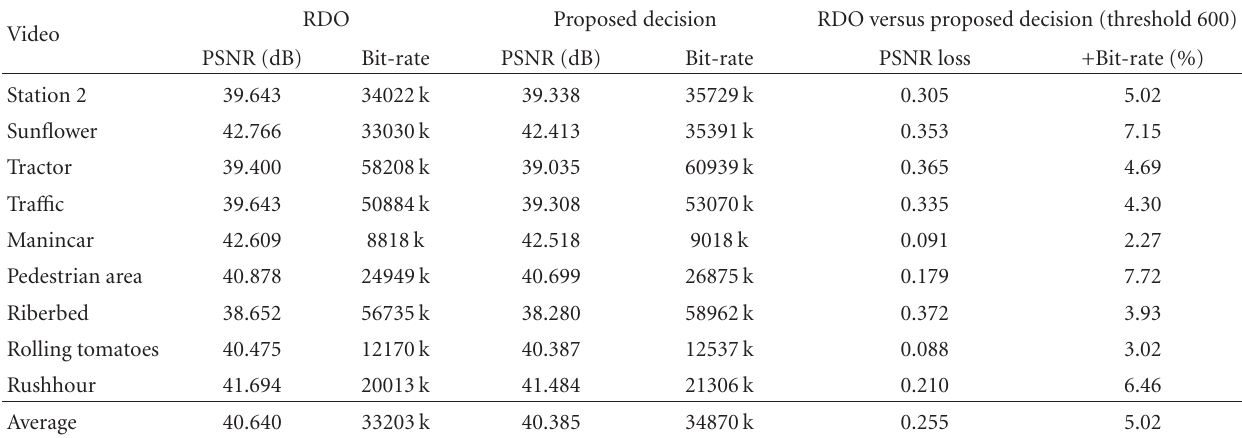
Table 2: Results of the proposed intramode decision and comparison with RDO-based decision.